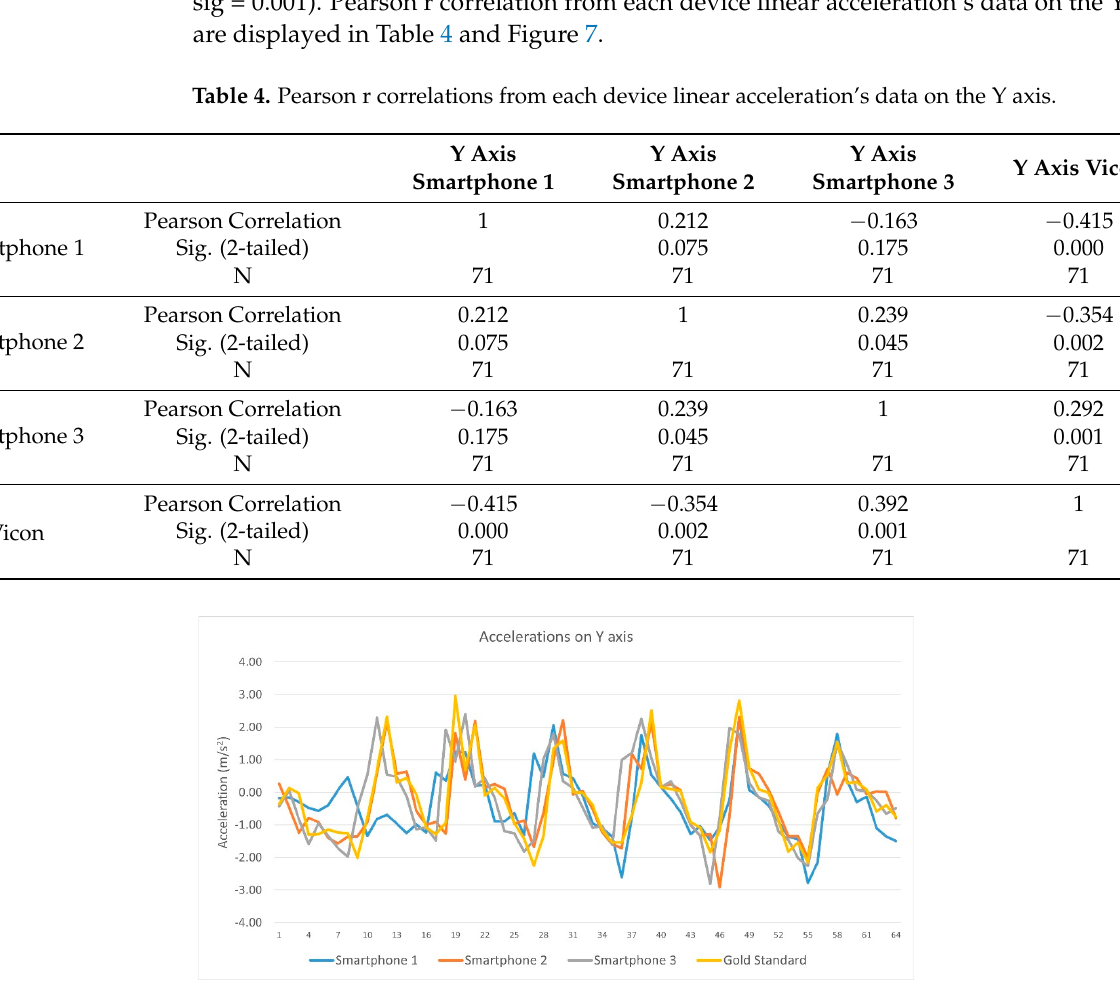
Figure 7. Pearson r correlations from each device linear acceleration’s data on the Y axis. Referring to linear acceleration data from each device on the Z axis, Pearson’s correlation coefficient (r) showed significant correlations between (a) Smartphone 1 and Vicon system (Pearson r = − 0.306, sig = 0.009), (b) Smartphone 2 and Vicon system (Pearson r = − 0.255, sig = 0.032) and (c) Smartphone 3 and Vicon system (Pearson r = − 0.330, sig = 0.002). Pearson r correlation from each device linear acceleration’s data on the Z axis are depicted in Table 5 and Figure 8. Table 5. Pearson r correlations from each device linear acceleration’s data on the Z axis. Z Axis Smartphone 1